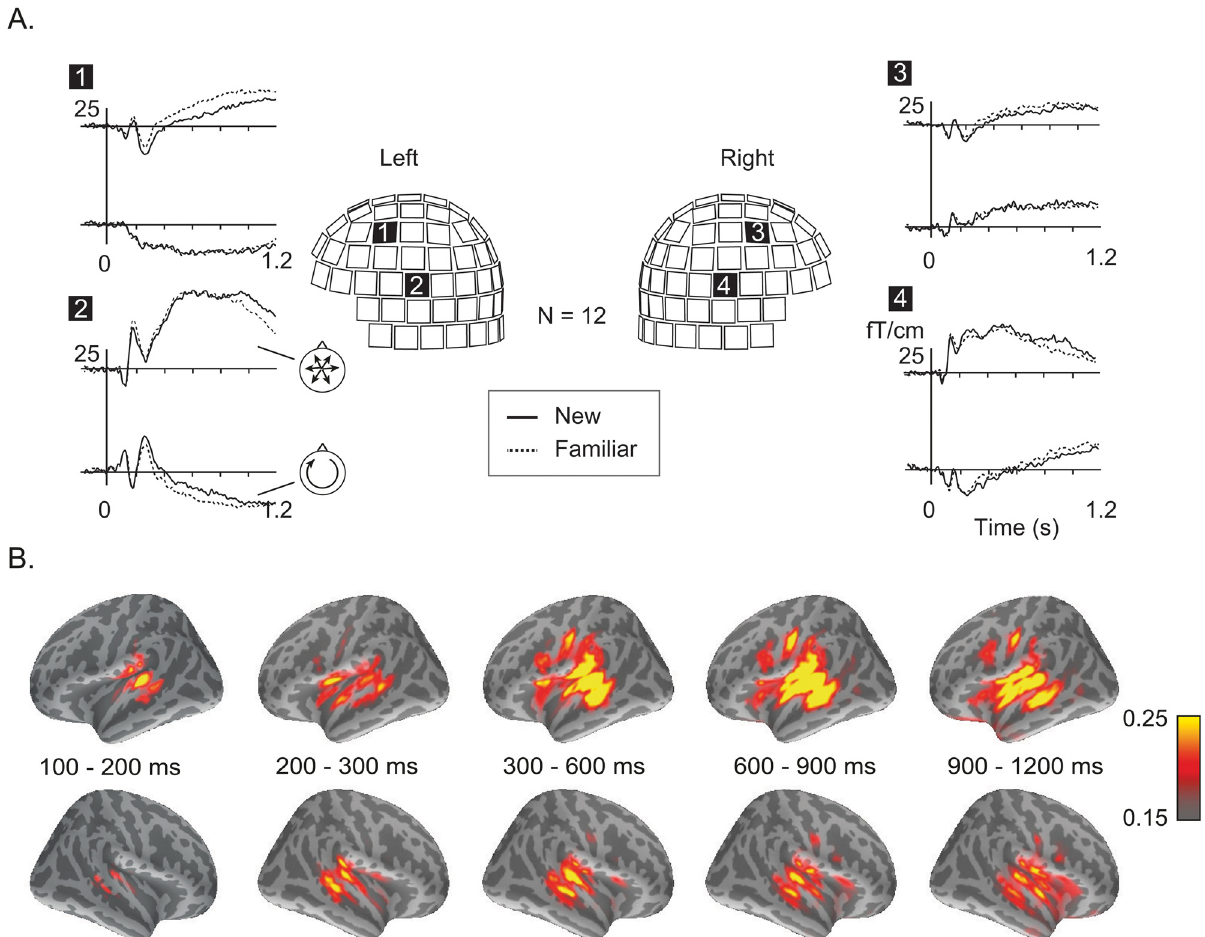
Fig 3. Sensor signals and source-level overview. (A) MEG sensor-level data. First ( ‘ new ’ ) and fourth ( ‘ familiar ’ ) presentation of the novel word forms in the learning phase, averaged over twelve participants and over languages. Stimulus effects are illustrated at two recording sites over the left hemisphere (sites 1, 2) and two (symmetrical) sites over the right hemisphere (sites 3, 4), with each site containing two planar gradiometers that are sensitive to orthogonal orientations of neural currents (cf. small schematic heads). Planar gradiometers detect the strongest signal directly above an active cortical area. (B) Source localization using minimum norm estimates (MNEs). The distribution of activation advancing from 100 to 1200 ms after stimulus onset (time slots of 100 or 300 ms), represented as an average over twelve participants. Salient activation maxima are evident in the bilateral temporal and left frontal cortices, but spatially close sources merge into a single blob, even when they have different underlying orientations of current flow.